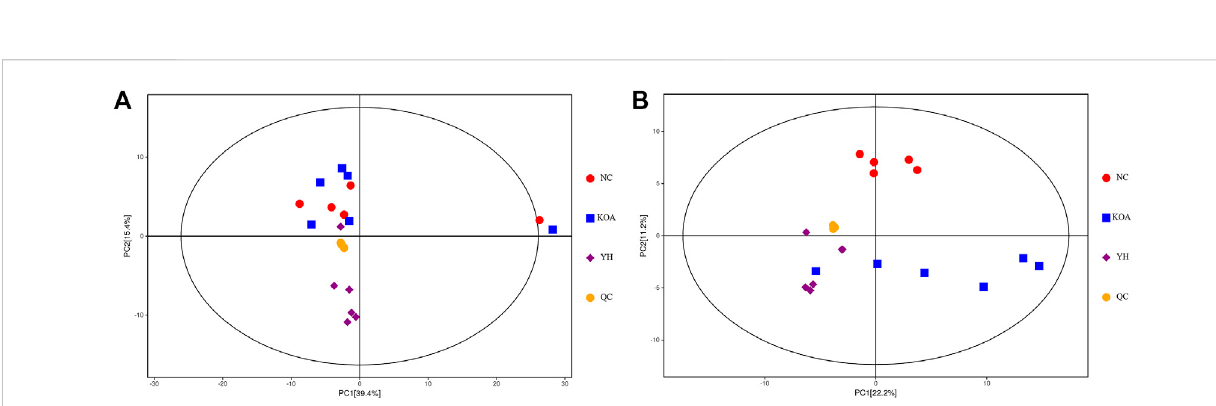
0.68 in the negative ion mode (Figure 5, D1: positive ion, D2: negative ion). All R 2 Y were very close to 1, indicating that the established model conformed to the real situation of the sample data. The intercept between the regression line of Q 2 and the longitudinal axis was less than zero. Meanwhile, with the gradual reduction of displacement retention, the proportion of the Y variable of displacement increased, and the Q 2 of random model gradually decreased. It showed that the model in this study had good robustness, and there was no over- fi tting phenomenon. Therefore, the OPLS-DA results further con fi rmed the successful establishment of our OA rat model and that YH administration could regulate the metabolic pro fi le of the rat.